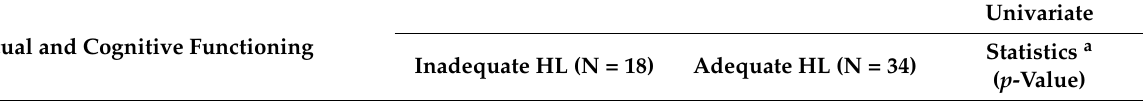
Table 3. Univariate analysis to compare the cognitive functioning with indices of health literacy